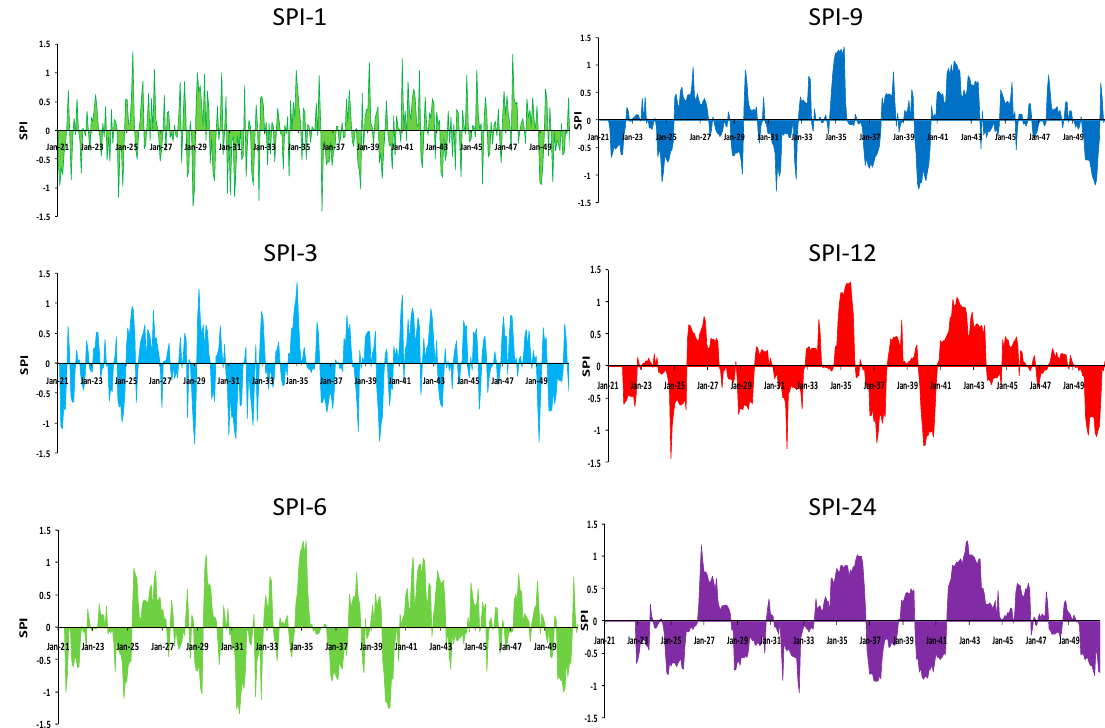
Figure 4. Standardized precipitation index (SPI)for multiple timescales under RCP4.5 scenario (2021–2050) for Danang station.